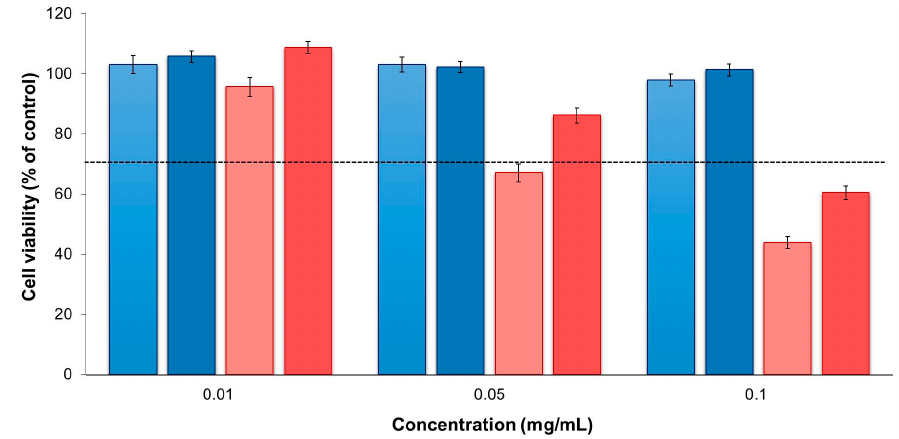
Figure 5. A549 ( lighter colour) and macrophage-differentiated THP-1 ( darker colour) cell viabilities after 24 h of exposure to free drugs, isoniazid ( blue ) and rifabutin ( red ). Results are expressed as mean ± SEM ( n = 3, six replicates per experiment at each concentration). Dashed line represents 70% cell viability.